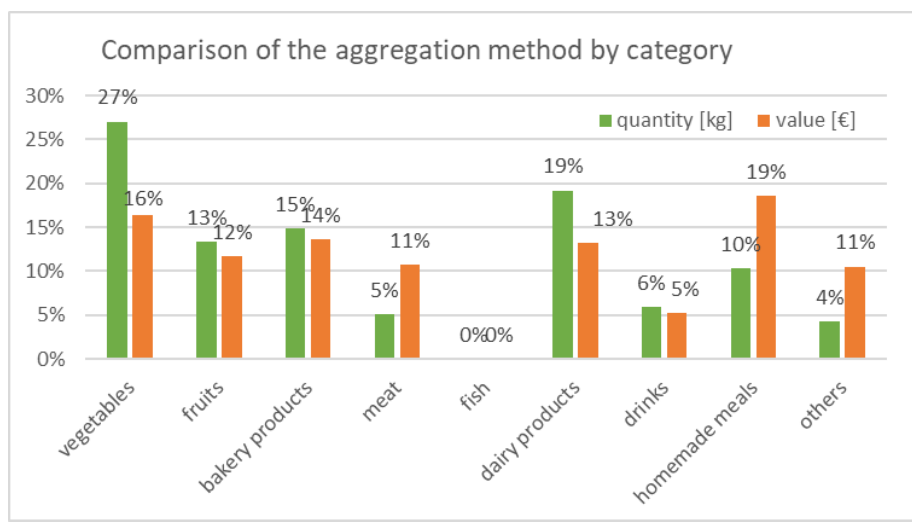
Figure 6. Diary—comparison of the aggregation method according to food category. Table 9. Regression